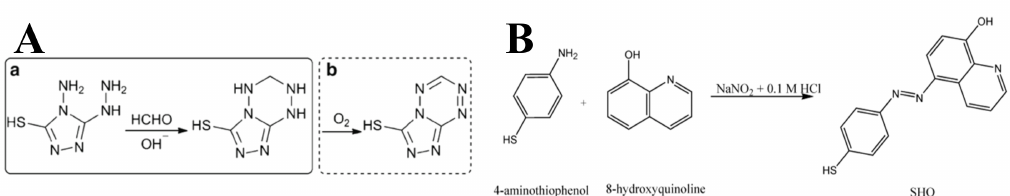
Figure 1. Scheme for SERS-based hydrazine detection derivatized with a phthaldialdehyde probe [6].